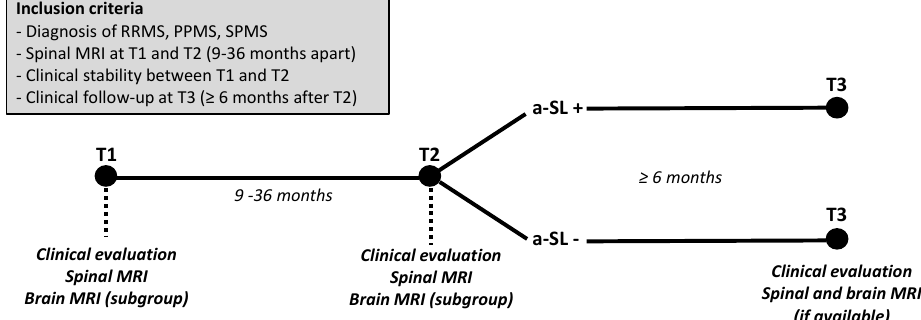
Figure 1. Inclusion criteria and study design. Spinal MRIs are performed at T1 (baseline) and T2 (9–36 months after T1) in clinically stable multiple sclerosis (MS) patients. When available, information on brain MRIs performed at T1 ( ± 60 days) and at T2 ( ± 60 days) were also collected and used for sensitivity analyses. Patients with vs. without asymptomatic spinal lesions (a-SL) at T2 are then compared in terms of clinical and radiological outcomes at T3 (>6 months after T2). RRMS: relapsing-remitting multiple sclerosis; PPMS: primary progressive multiple sclerosis; SPMS: secondary progressive multiple